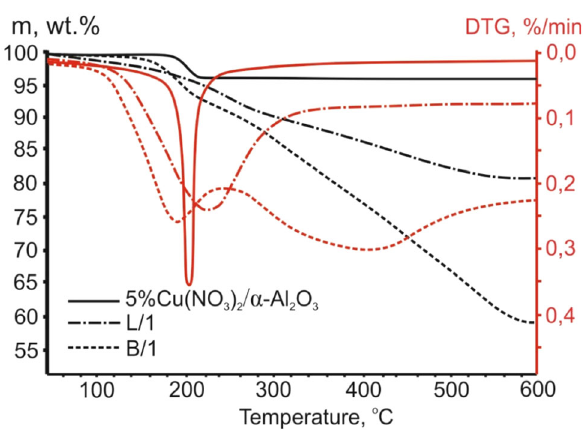
Fig. 6 TG- and DTG-curves of the thermal decomposition of copper nitrate and energetic coals. The nitrogen flow rate was 60 mL/min; the heating rate was 2.5 (cid:3) C/min; the sample loading was about 17 mg